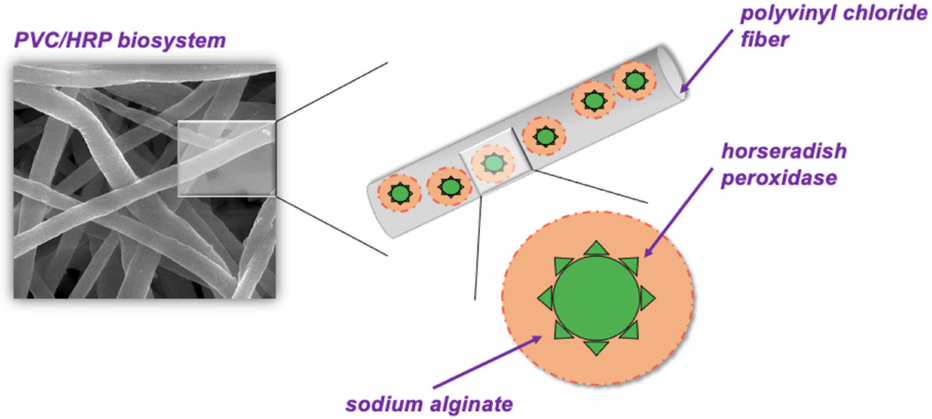
Figure 5. The scheme of electrospun PVC with encapsulated